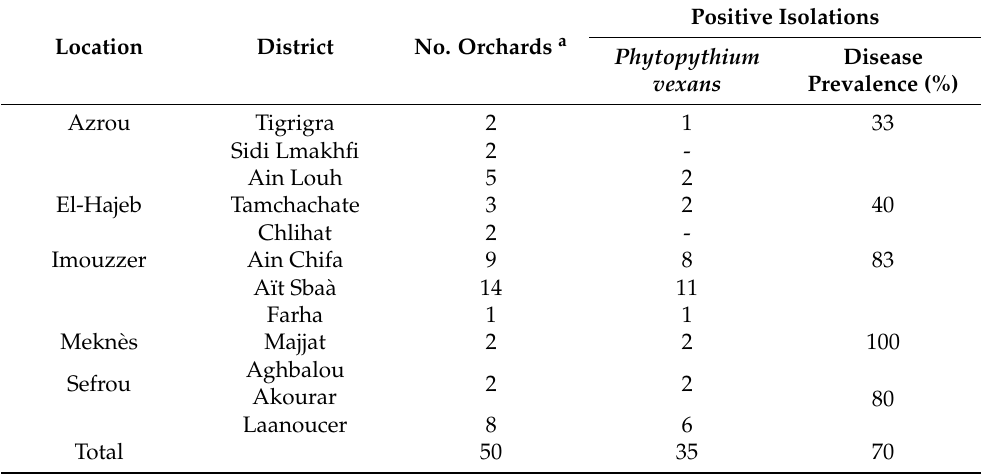
Table 2. Occurrence and distribution of pathogenic oomycetes in apple and pear orchards in different regions in Morocco.